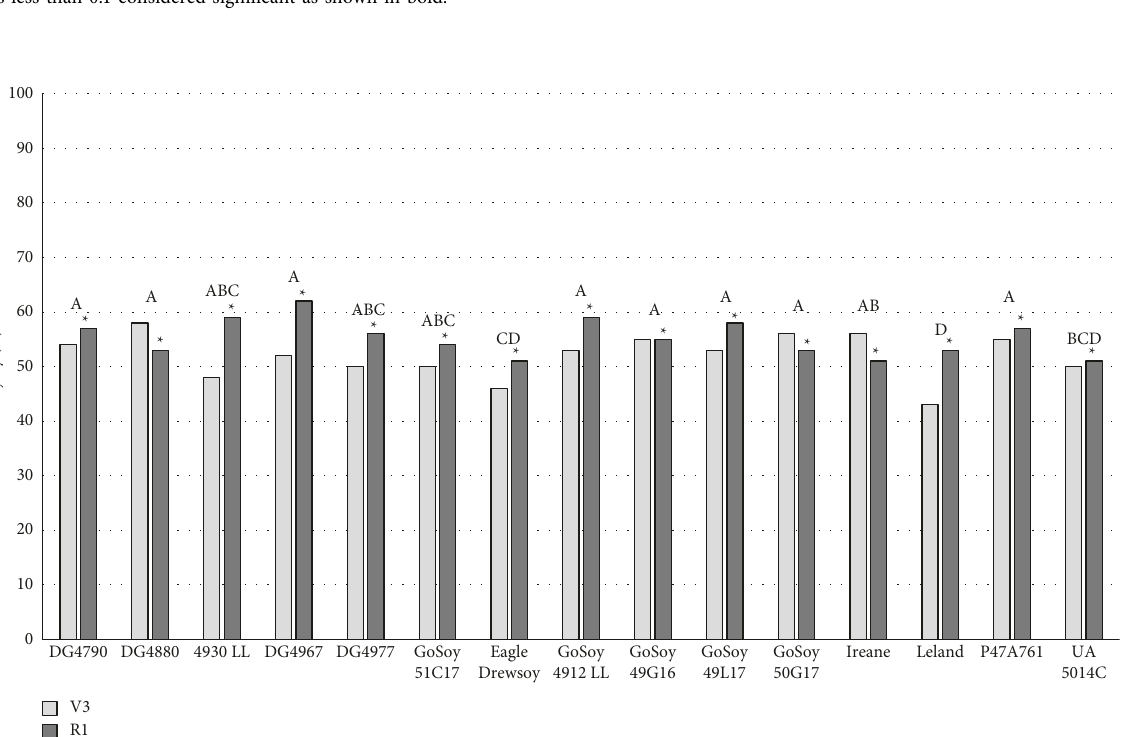
Figure 1: Visual estimates of soybean injury at 21 days after treatment according to the main effects of application timing and cultivar for the cultivar experiment conducted in Fayetteville, AR in 2018. The occurrence of a greater injury for the main effect of application timing, according to multiple comparisons analysis ( α � 0.05), is denoted by an asterisk over the R 1 treatment. Differences among the main effect of cultivar are denoted by uppercase letters. Treatments not sharing any uppercase letter are significantly different according to multiple comparison analysis α � 0.05